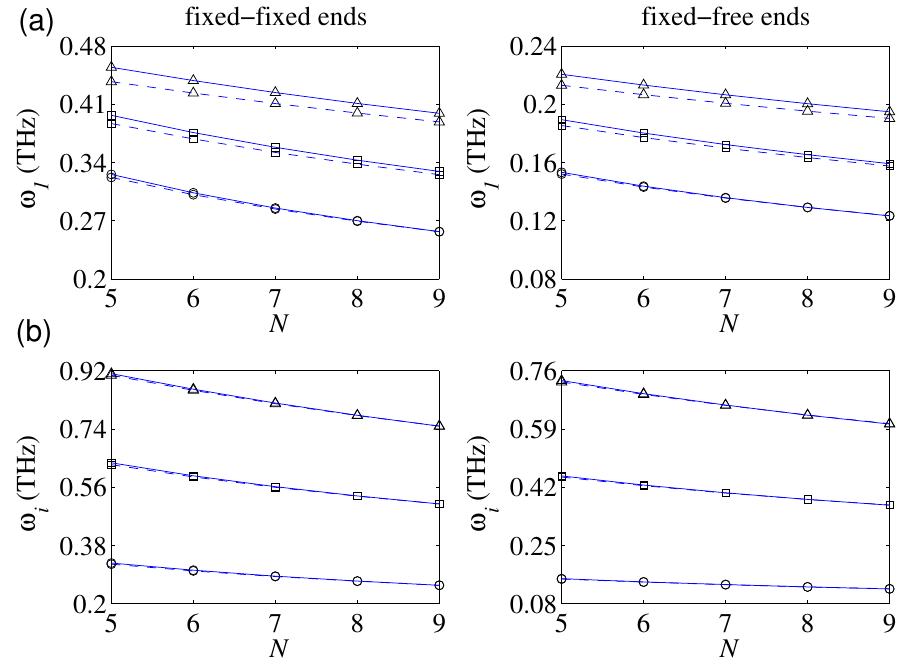
Figure 6. The natural frequencies as a function of the number of uniformly placed defects with and without considering the surface effect: ( a ) fundamental frequency for different defect parameters; (( ◦ ) ¯ k i = 4, ( (cid:3) ) ¯ k i = 8, ( (cid:52) ) k i = 16) ( b ) first, second, and third frequencies for the case of ¯ k i = 4; (( ◦ ) ω 1